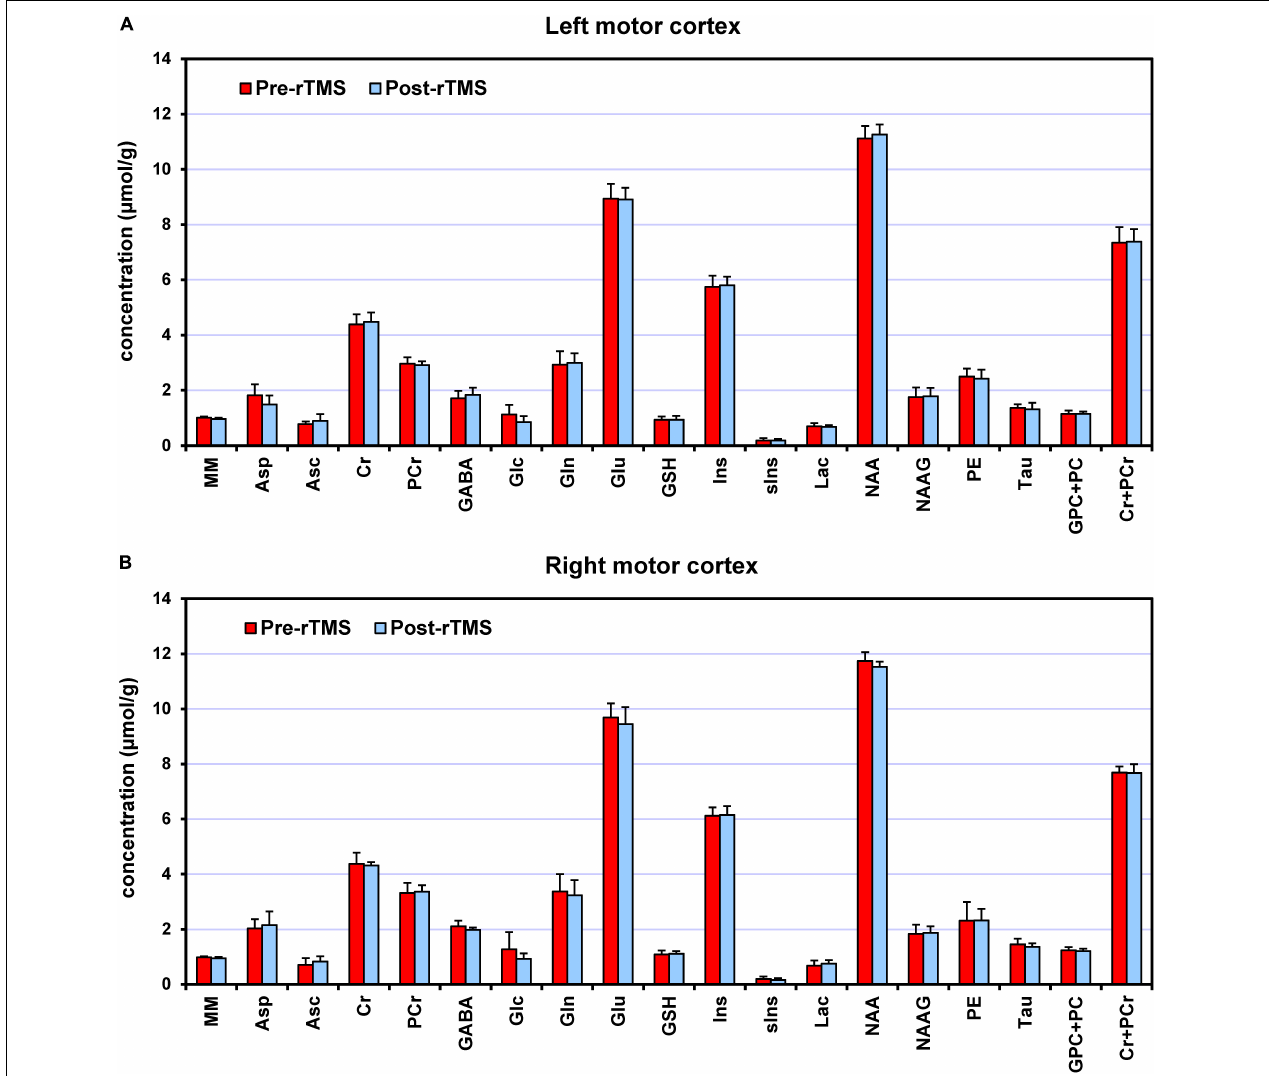
FIGURE 3 | Neurochemical profiles pre-rTMS (red) and post-rTMS (blue), from left (A) and right (B) motor cortices. Bar diagrams show mean ± SD across the subjects who underwent the 1-Hz rTMS ( N = 7).